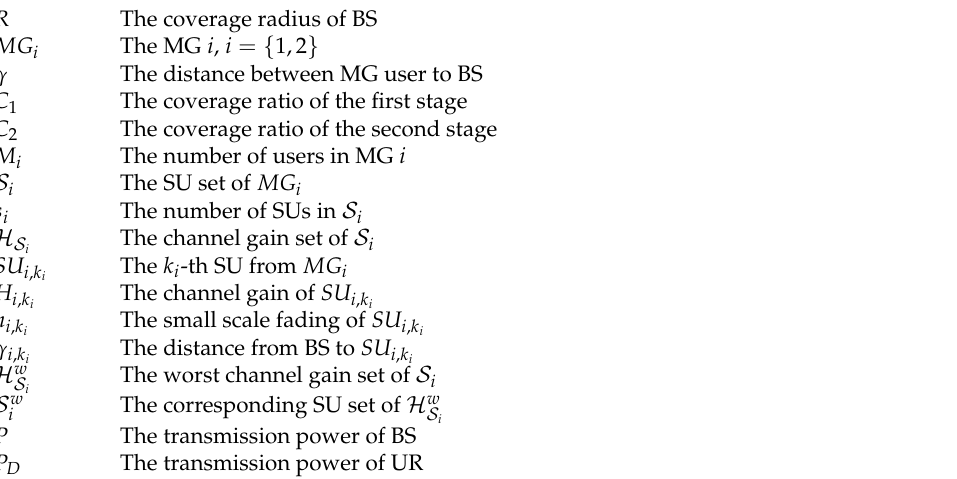
Table 1. Notations of mathematical